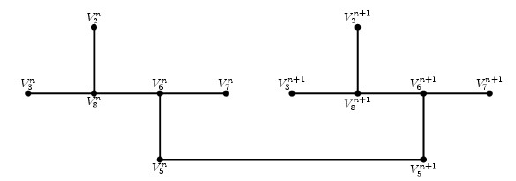
Figure 5. Subgraph of ][ TG